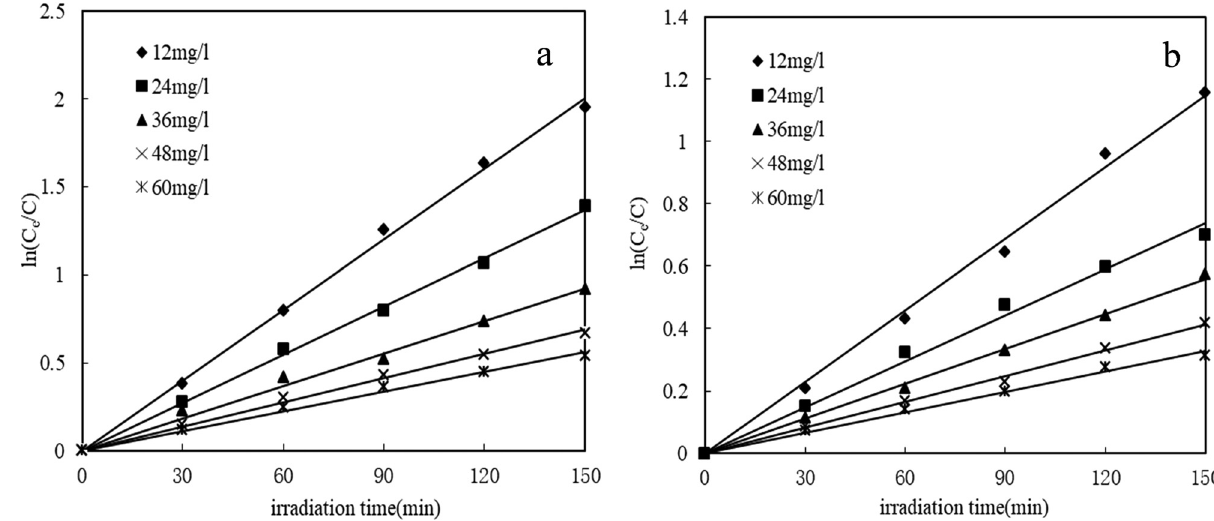
Figure 7: Degradation - fi tting curves of NB by SiO 2 ( AG ) /T - ZnO ( a ) and T - ZnO ( b )